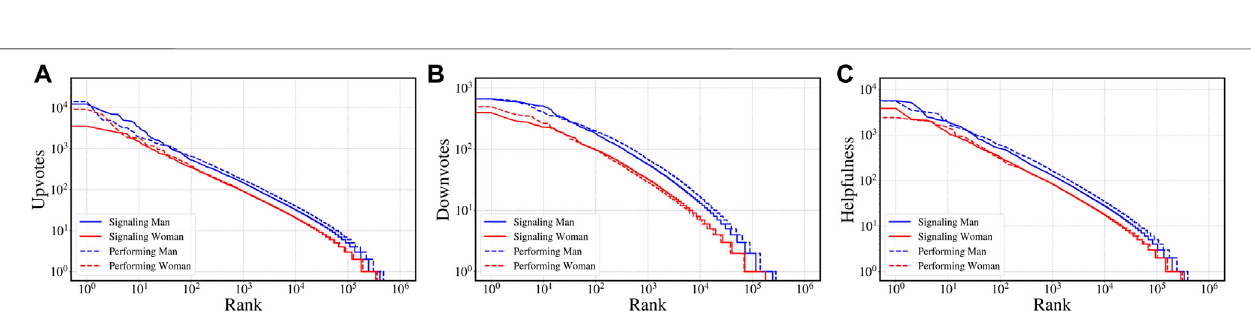
FIGURE3| Determiningthecon fi dencethreshold. (A) Onlabeledtestsetweplotaccuracyversusmodelcon fi dence.Weobservethatforacon fi dencethresholdof at least 0.7, we achieve an accuracy of 0.82 and it reduces with lower thresholds. (B) For different con fi dence thresholds we measure the size of the undisclosed set (in fraction). We observe that with a con fi dence threshold of at least 0.7, the undisclosed set is ∼ 70% of the original set and this reduces drastically as we increase the threshold. Guided by theabove result, to strike abalance betweenaccuracyand suf fi cient sizeofthe undisclosed set,wedecideon acon fi dence thresholdof0.7.